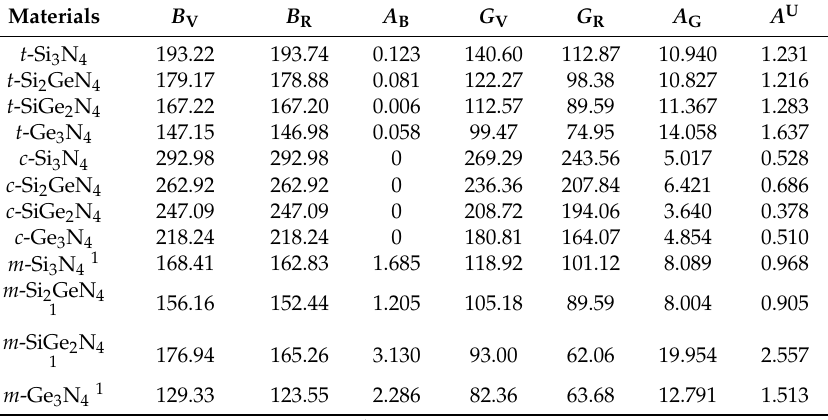
Table 3. Calculated bulk modulus B V , B R and shear modulus G V , G R by the Voigt and Reuss method respectively; percent compressibility of bulk modulus and shear modulus factors ( A B , A G ) %